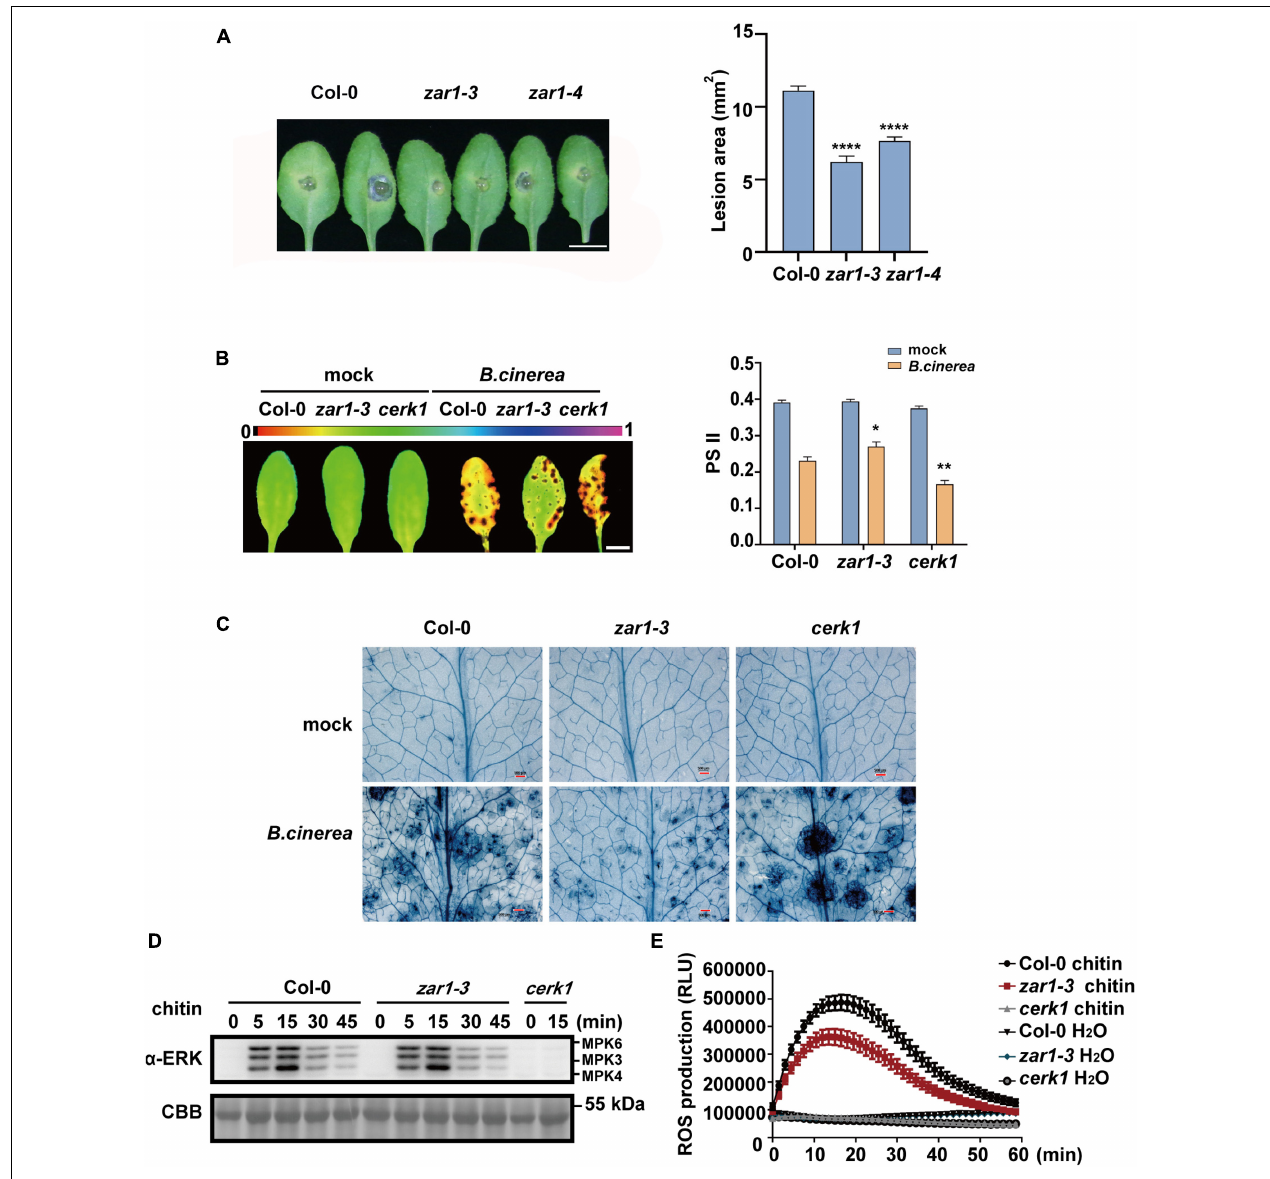
FIGURE 2 | ZAR1 functions in the resistance to the fungal pathogen Botrytis cinerea . (A) ZAR1 functions in the resistance to the fungal pathogen Botrytis cinerea . Lesions on the leaves of zar1-3 , zar1-4 mutant, and Col-0 plant were observed at 48 h after inoculation with B. cinerea . Lesion sizes were analyzed. Error bars represent SEM from means of 16 leaves from each line. Asterisks indicate significant differences compared with Col-0 plant (**** P < 0.0001, Student’s t -test). Scale bar = 1 cm. (B) Chlorophyll fluorescence imaging and quantification of (cid:56) PSII was measured in zar1-3 mutant, cerk1 mutant, and Col-0 plant, at 36 h after B. cinerea spray. Error bars represent SEM of 16 leaves from each line. Asterisks indicate significant differences between each mutant and Col-0 plant (* P < 0.05, ** P < 0.01, Student’s t -test). (C) Visualization of cell death in infected leaves at 36 h post-infection. Representative images of trypan blue (TPB) stained leaves are shown. Scale bar = 500 µ m. (D) Chitin-triggered MAPK activation in zar1-3 mutant, cerk1 mutant, and wild type Col-0. 10-day-old seedlings were treated with 200 µ g/mL chitin at the indicated time points. MAPK activation was detected with an anti-pERK antibody. cerk1 mutant was included as a control. Equal loading is demonstrated by CBB (Coomassie brilliant blue) staining of Rubisco (below). The experiments were repeated three times, with similar results. (E) Leaves of the 4-week-old zar1-3 mutant, cerk1 mutant, and Col-0 plants were treated with 200 µ g/ml chitin and incubated with luminol and horseradish peroxidase to detect ROS. Luminescence was recorded at different time points as indicated. Error bars represent SEM of data derived from replicate samples ( n = 12). The chemiluminescence was measured in a time-course manner using a microplate reader (Varioskan LUX, Thermo Fisher Scientific Inc., MA, United States).